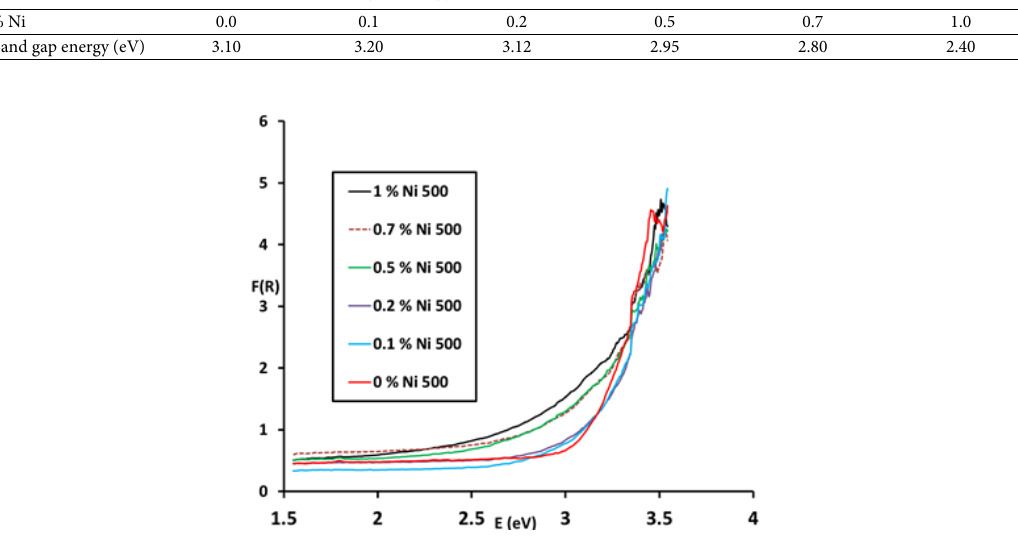
calcined at 500 2